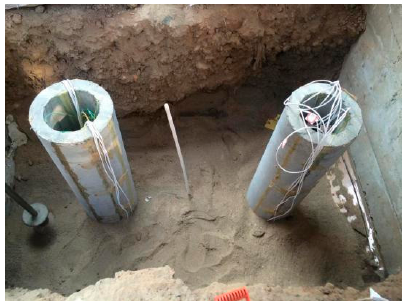
Figure 2. Soil layered compaction.